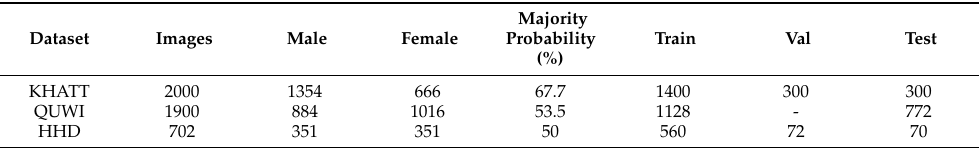
Table 1. The total amount of training, validation, and testing images in each dataset. The ‘ma- jority probability’ column describes the imbalance in the dataset (percentage of the samples from larger class).